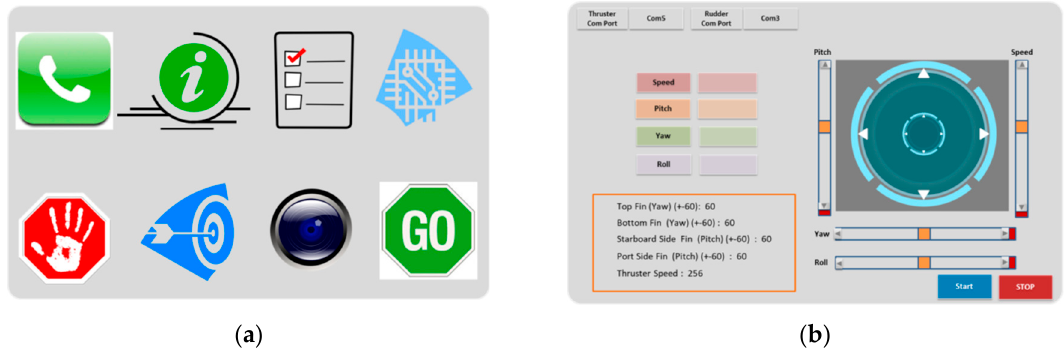
Figure 3. User interfaces of the autonomous underwater vehicle (AUV) control system including ( a ) the administration interface and ( b ) the postdriver system page.